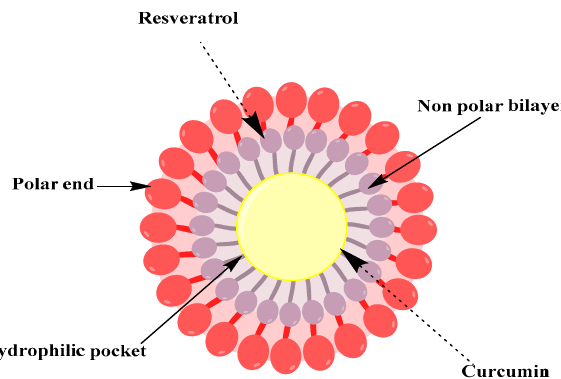
Figure 4. Liposomes co-encapsulated with curcumin and resveratrol for PCa delivery. Reproduced from [79] with permission from DeGruyter, 2017.